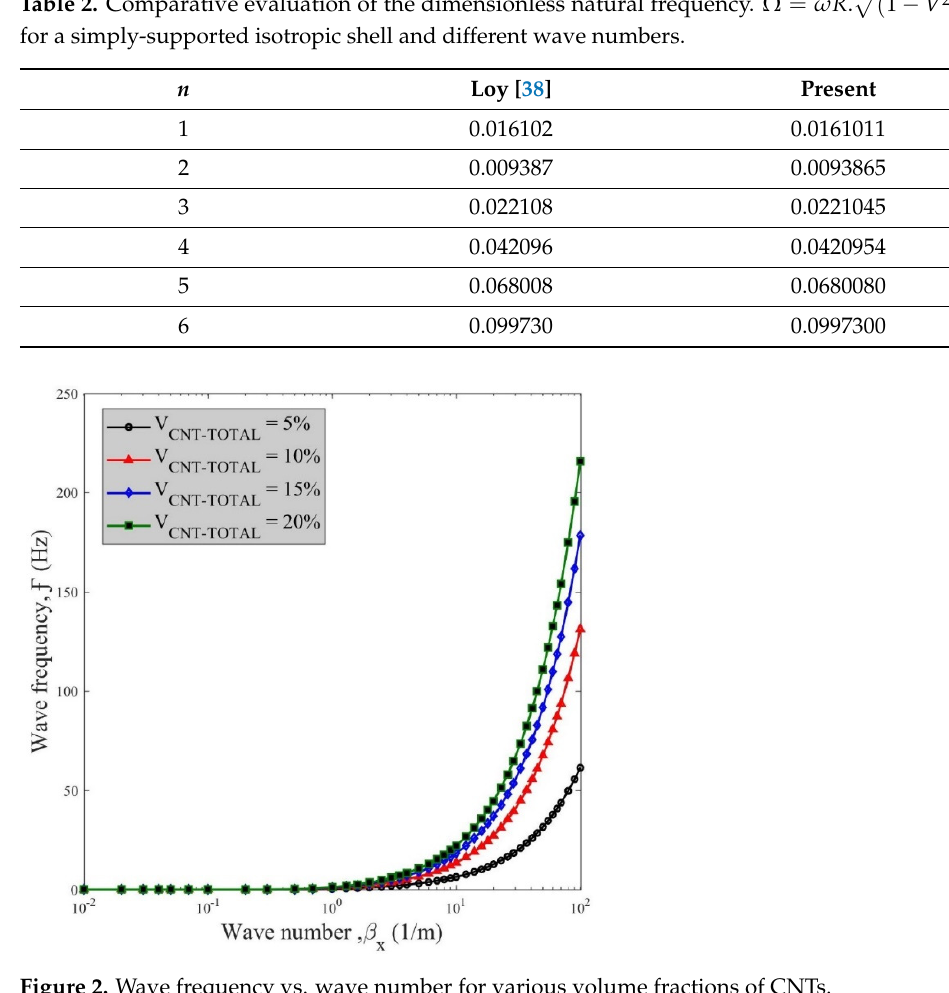
Figure 2. Wave frequency vs. wave number for various volume fractions of CNTs.